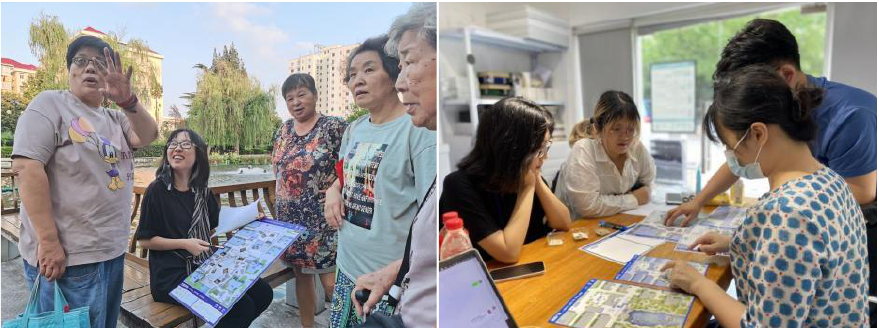
Figure 5. Active participation of community residents in the discussion. We iterated on the com- munity space approach by giving the co-created community map to more local residents for sug-